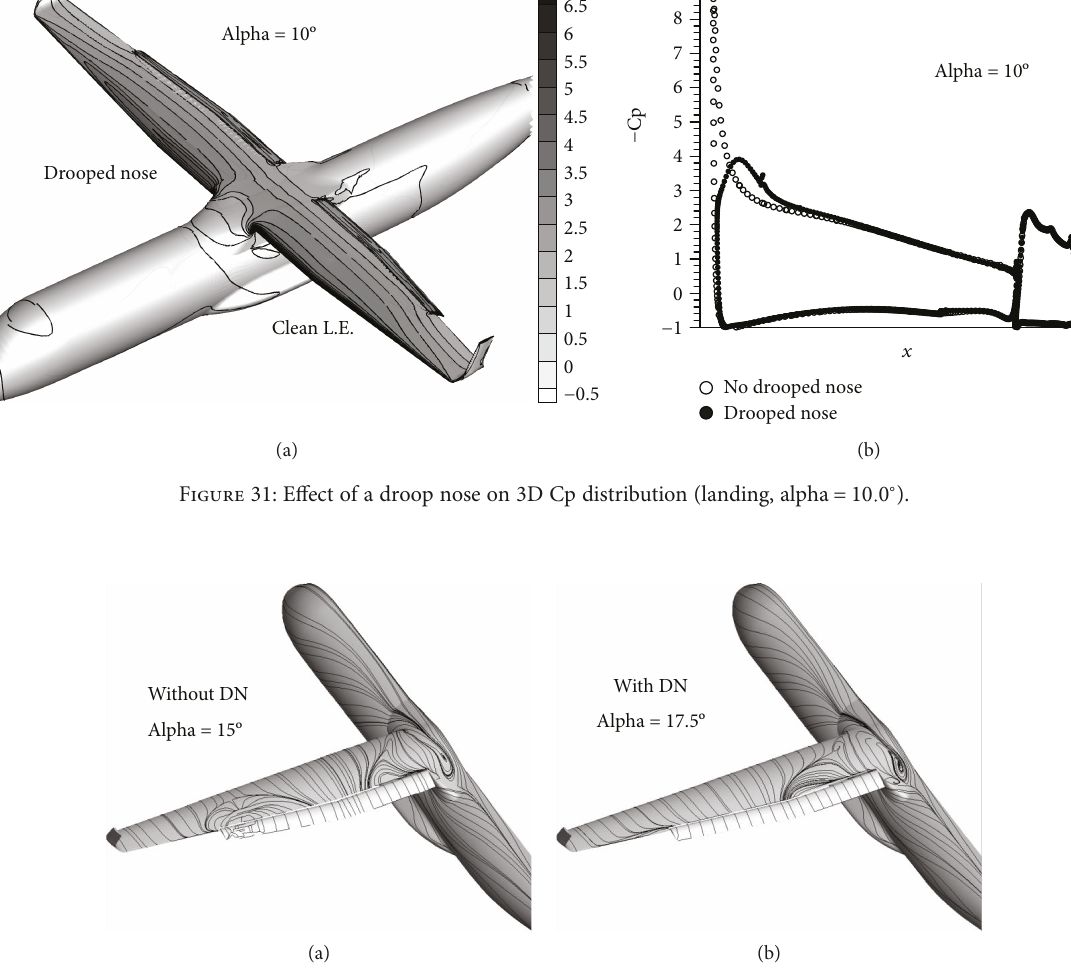
Figure 32: E ff ect of a droop nose on stall process for takeo ff con fi guration: computed friction